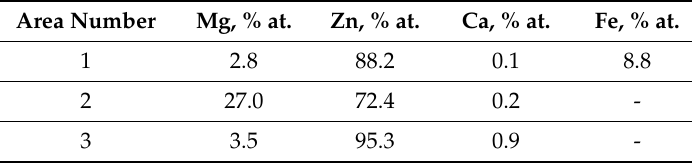
Figure 3. Light microscope image of microstructure revealed after etching in 2% nital solution for Zn 87 Mg 9 Ca 4 bulk material sample—before the melt spinning process.